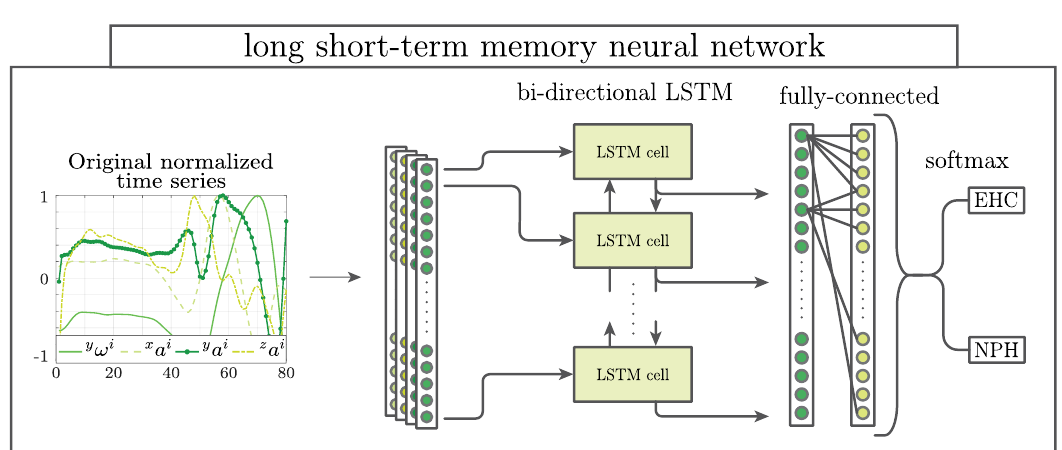
Figure 1. The long short-term memory (LSTM) classifier takes as input a four channel signal composed of the angular velocity around the ankle’s mediolateral axis y ω i and the three linear accelerations x a i , y a i and z a i during one stride. The first LSTM cell uses the initial state of the network and the first time sample to update the current cell state and compute the output. Subsequent time samples are fed into the corresponding LSTM cell, which makes use of previous cell states to learn about long and short-time dependencies within and between the signal channels.